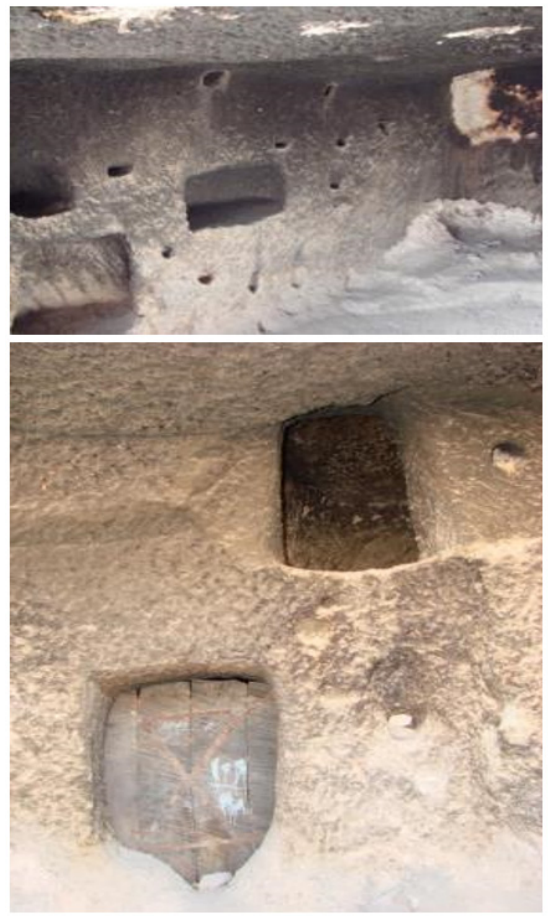
Figure 13. Fine excavation technique used in doorways, niches and interior space of rock-cut rooms in Meymand.